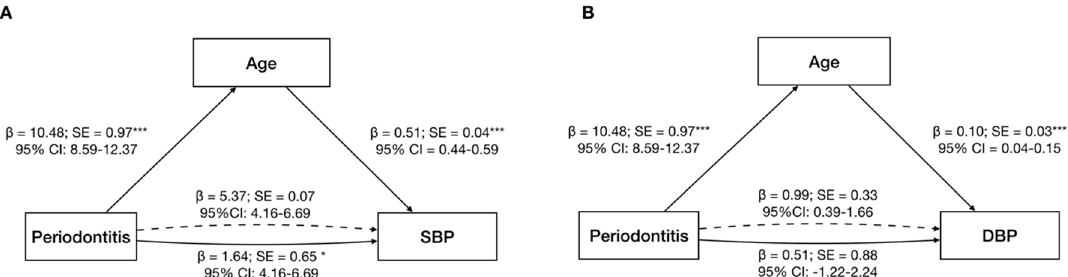
Figure 2. Mediation analysis of age for the association between periodontitis and systolic blood pressure ( A ) and diastolic blood pressure ( B ). ß—Standardized estimates; CI—Confidence interval; DBP—Diastolic Blood Pressure; SBP—Systolic Blood Pressure; SE—Standard error. * p < 0.05, ** p < 0.01, *** p < 0.001. Solid lines = direct effect; dashed lines = indirect effect.